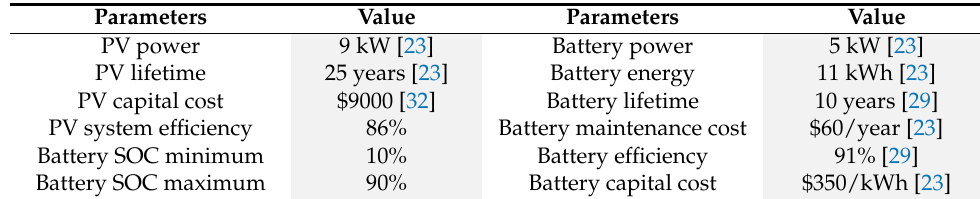
Table 4. Parameters of the proposed